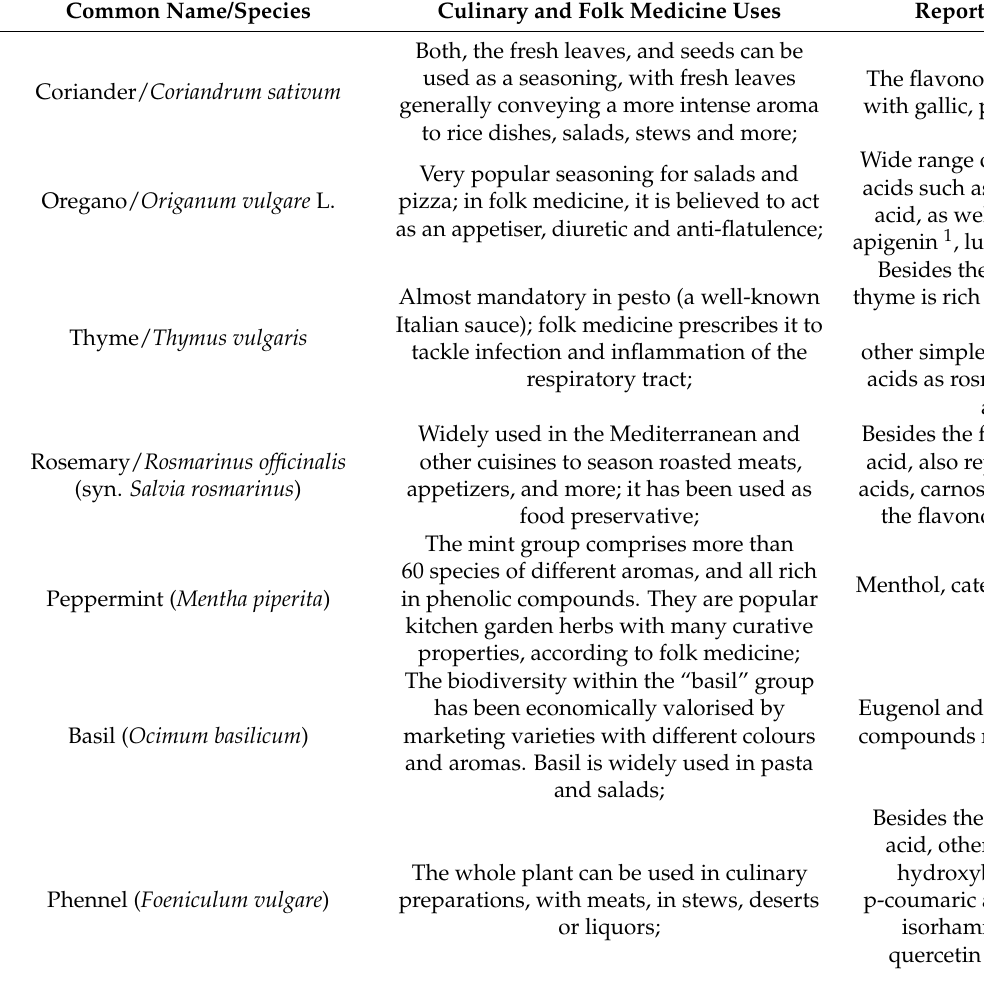
Table 1. Prominent phenolic compounds, health-promoting actions and other properties of aromatic herbs commonly used in Mediterranean